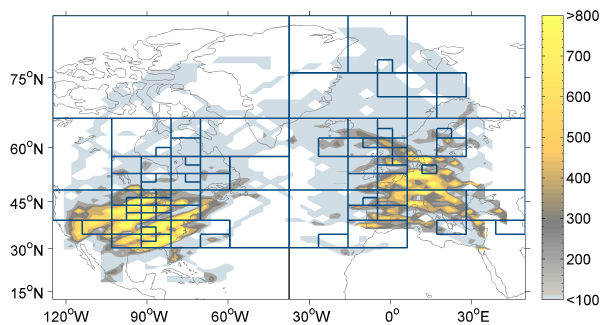
Figure 8. Multi-Resolution (MR) Map for the high-resolution case with discrete Meyer basis functions. Each box represents the scale of the basis function and its position.